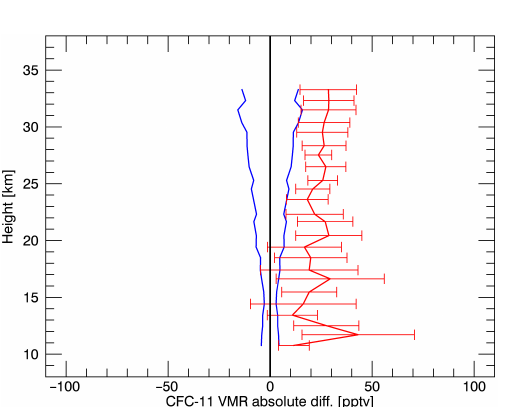
Figure 14. Same as Fig. 1, but instead of CH 4 now CFC-11. Figure 15. Same as left panel of Fig. 3, but instead of CH